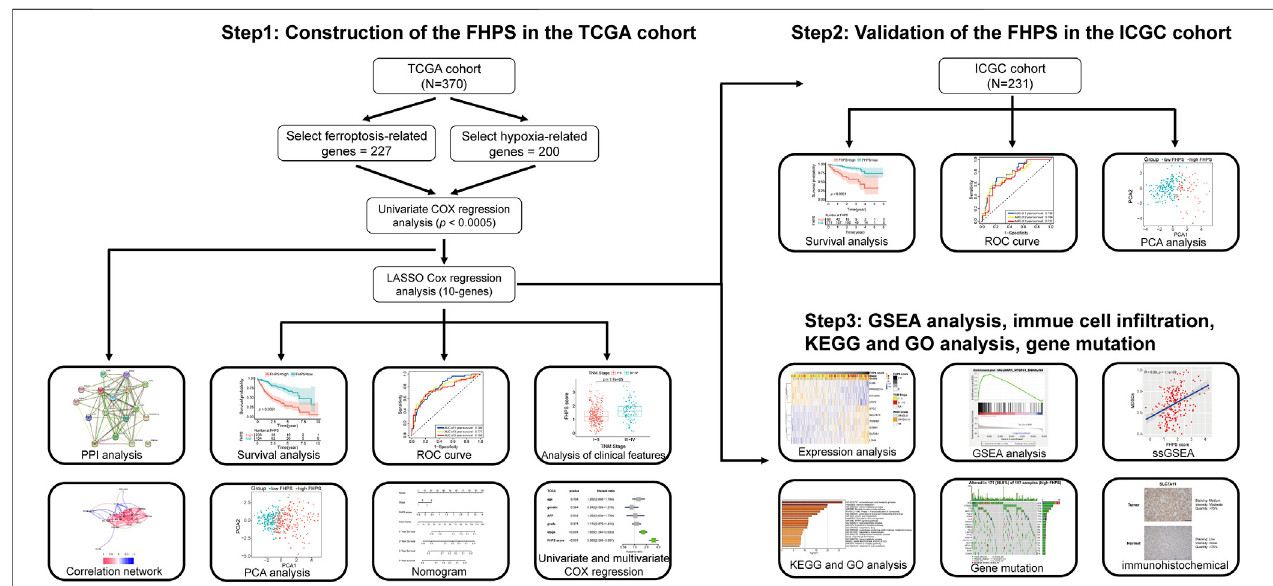
FIGURE 1 | Study fl ow